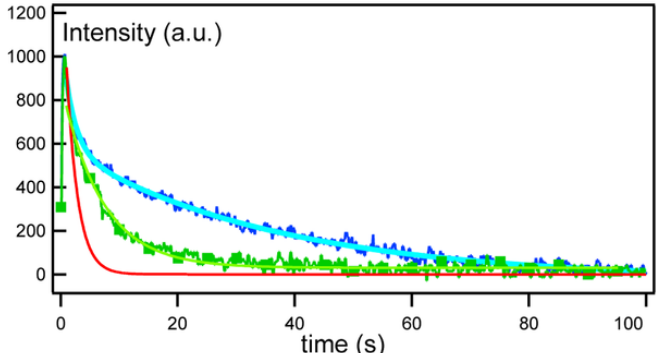
Figure 4. FRAPP curves of biotinylated transmembrane peptide (B-L complexes, ratio r = [B]/[L ]; where r = 0 (solid red line), r = 0.2 (green squares), and 12 r = 1.9 (blue solid line). From [31], by permission from PLoS ONE.